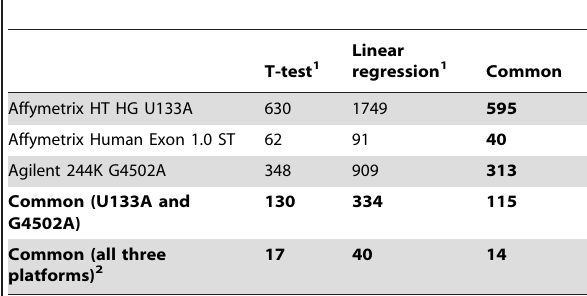
Table 2. Number of differentially expressed genes between Old and Young GBM samples for three transcriptomic